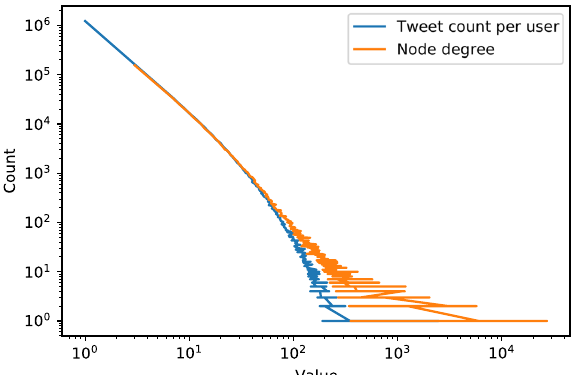
Fig. 2 The user tweet count and node degree distributions in our Twitter reply network collection